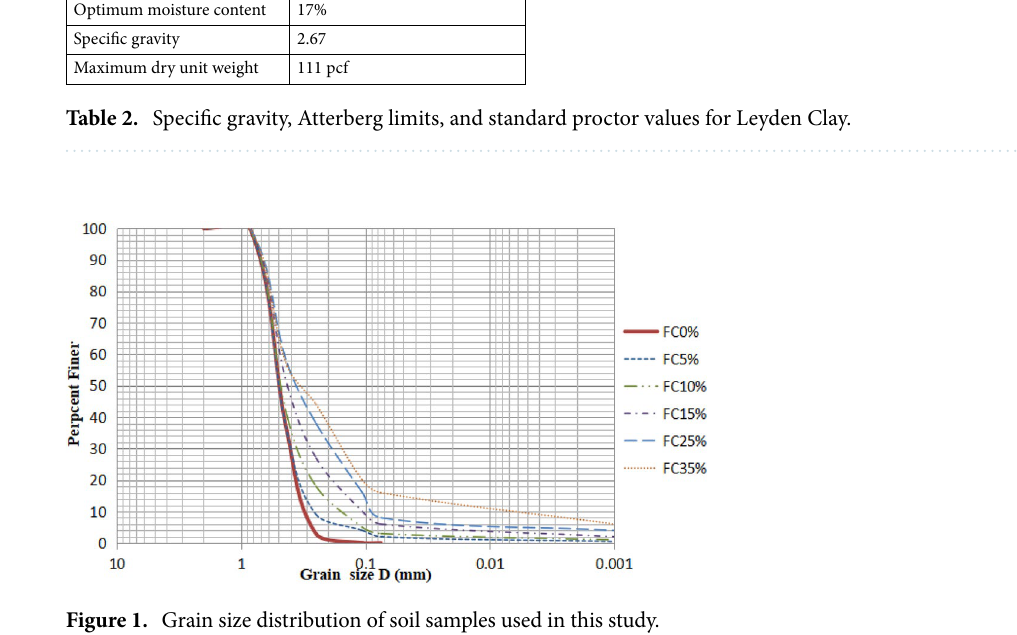
Figure 1. Grain size distribution of soil samples used in this